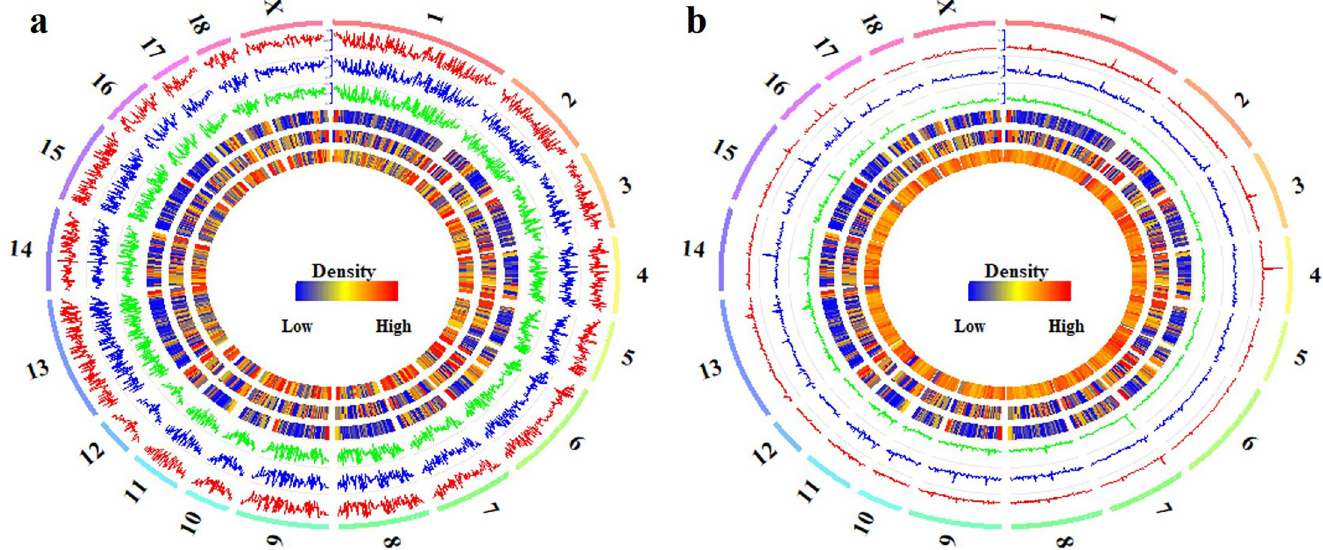
Fig 2. Global methylation of CpGs and CpHs in the pituitaries. The global CpG (a) and CpH (b) methylation levels in Pre- (track 1), In- (track 2) and Post-pubertal stage (track 3) of the pituitary tissue, from outside to inside, were quantified per 1Mb window. The densities of CGIs (track 4), genes (track 5) and CpGs (track 6 in a ) or CpHs (track 6 in b ) were also quantified per 1 Mb window. The labels outside of track 1 represent the chromosomes of the porcine genome.